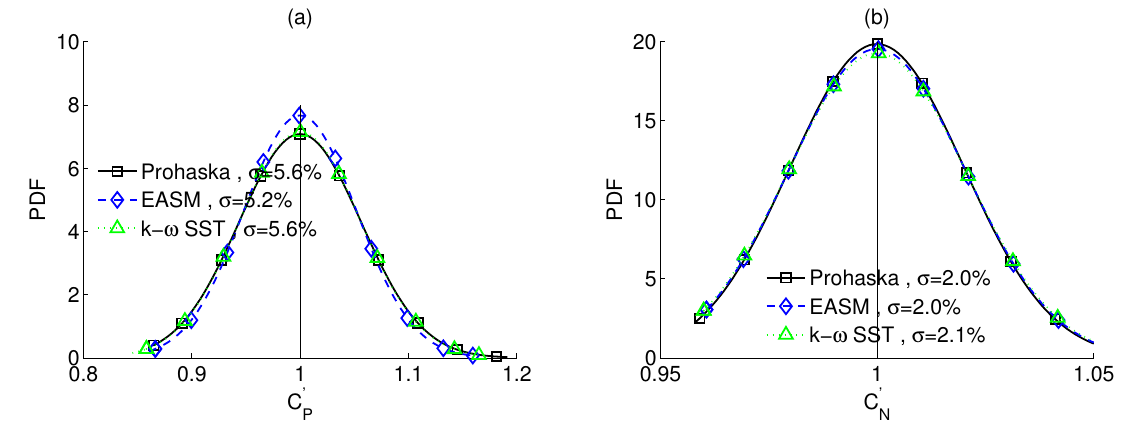
Figure 14. The probability density functions (PDFs) of the normalized correlation factors for the standard ITTC-78 method and using CFD-based form factors with two different turbulence models. ( a ) C (cid:48)